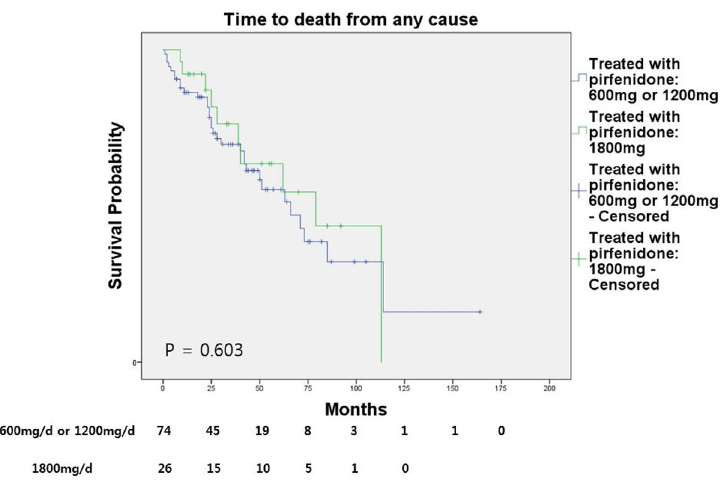
Fig 2. Overall survival of IPF patients according to the pirfenidone dose–full recommended dose of 1800 mg/day vs. relatively low-dose of 1200 mg/day or less.